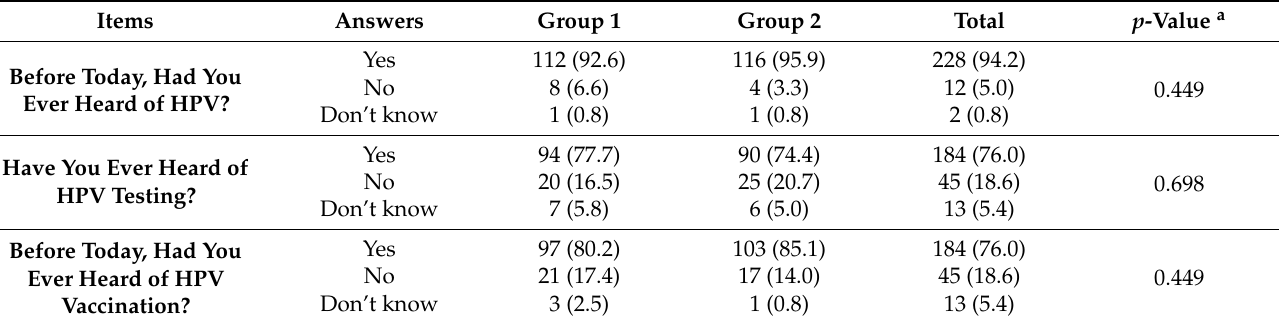
Table 2. General HPV knowledge and awareness at